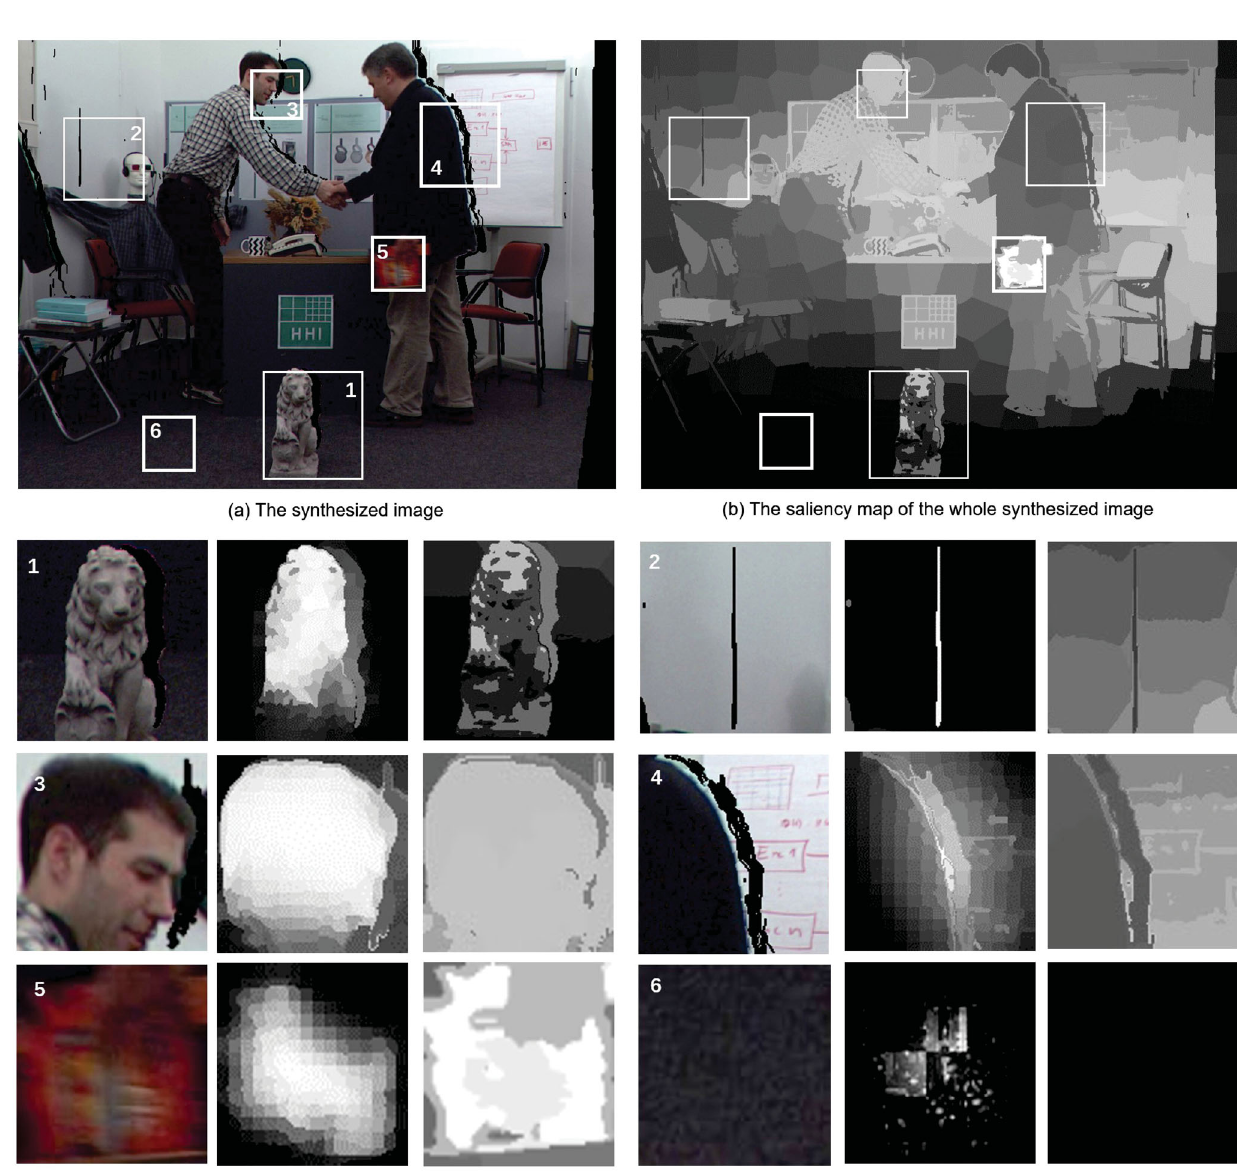
Fig. 4 Saliency maps for a synthetic image and its local patches. (a) Synthetic image. (b) Associated saliency map, with brighter intensity indicating stronger saliency. (c) Six chosen small patches extracted from the synthetic image, the corresponding patch saliency maps using the same saliency model, and the corresponding region extracted from the image saliency map. Note that geometric distortions appear differently in the patch saliency map and the image saliency